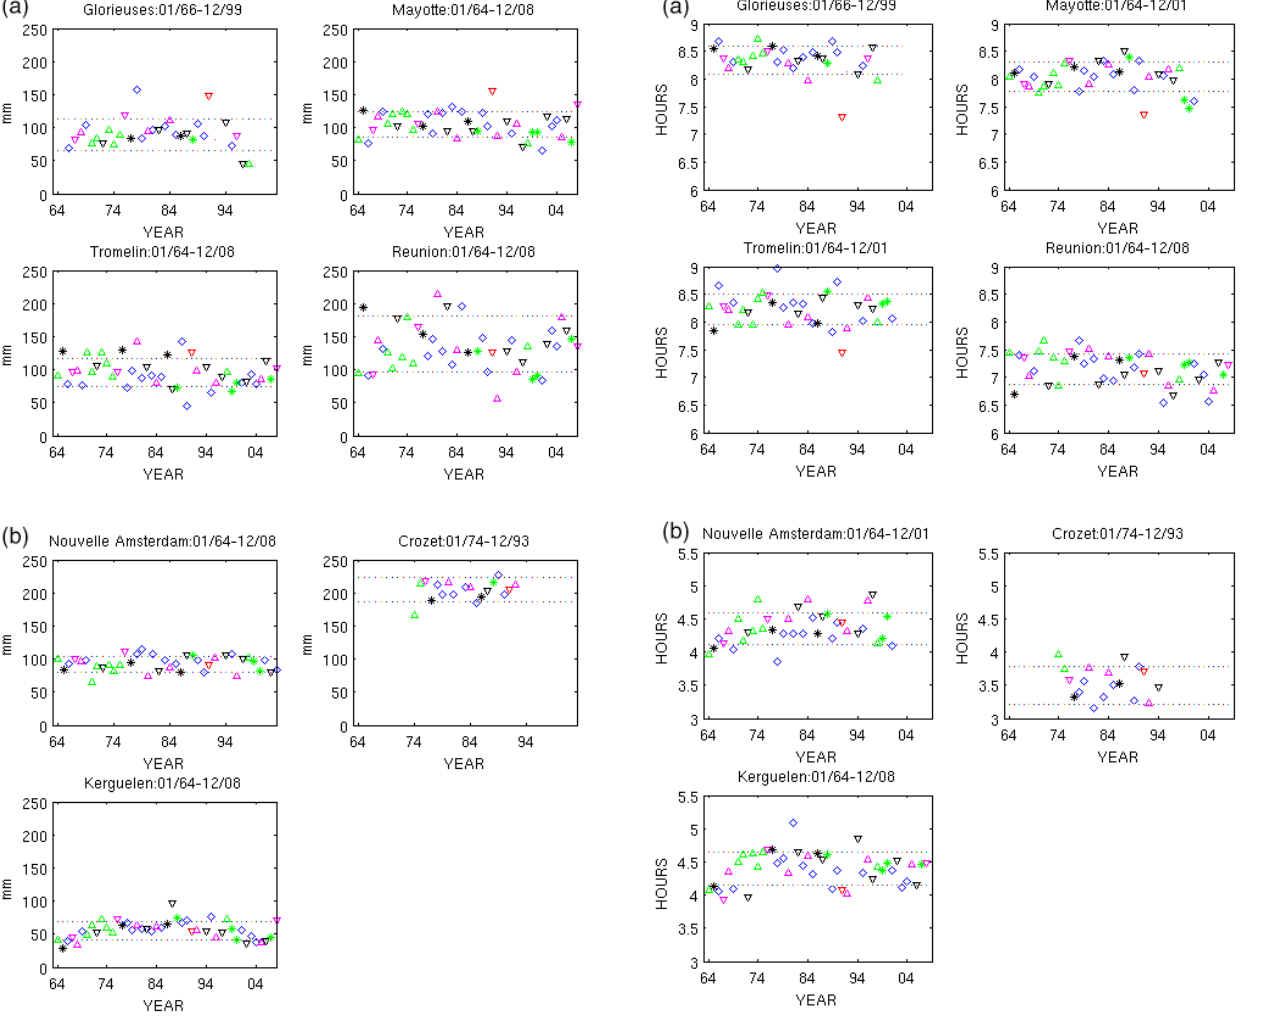
Figure 3. Same as Fig. 2 but for precipitation. Figure 4. Same as Fig. 2 but for sunshine